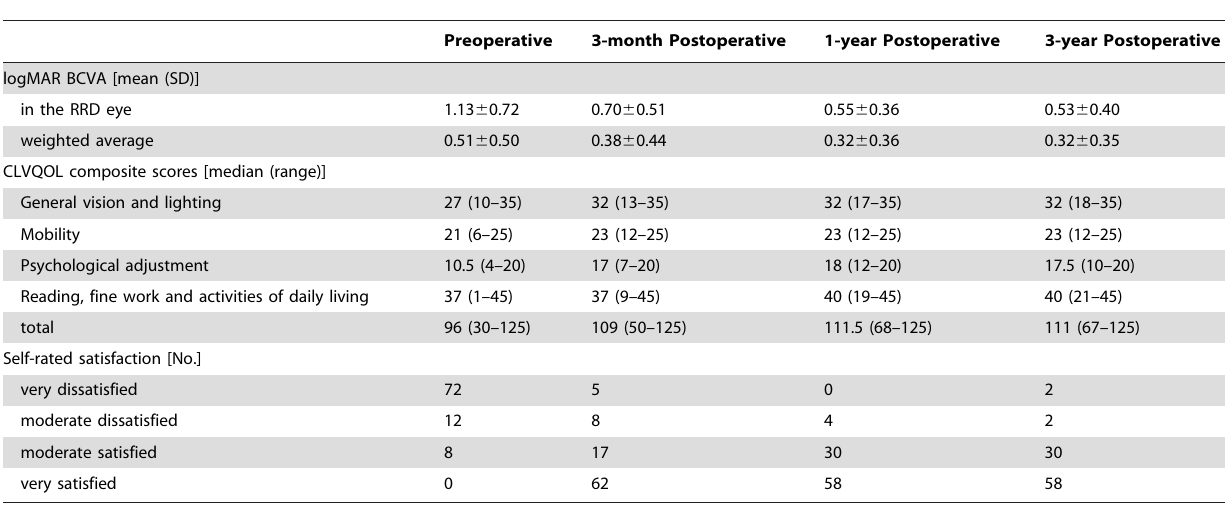
Table 2. Preoperative and postoperative logMAR BCVA, CLVQOL scores and self-rated satisfaction degrees in 92 RRD patients*.